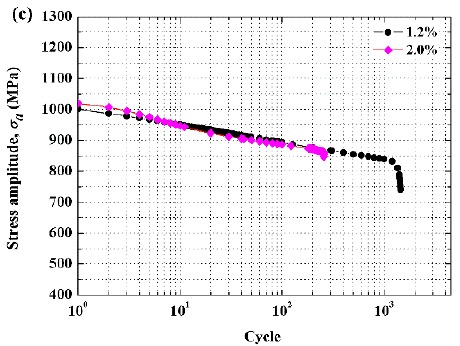
Figure 9. Stress amplitude σ a variations for ( a ) as-built selective laser melting (SLM), ( b ) annealed SLM, and ( c ) wrought samples at different strain amplitude levels.